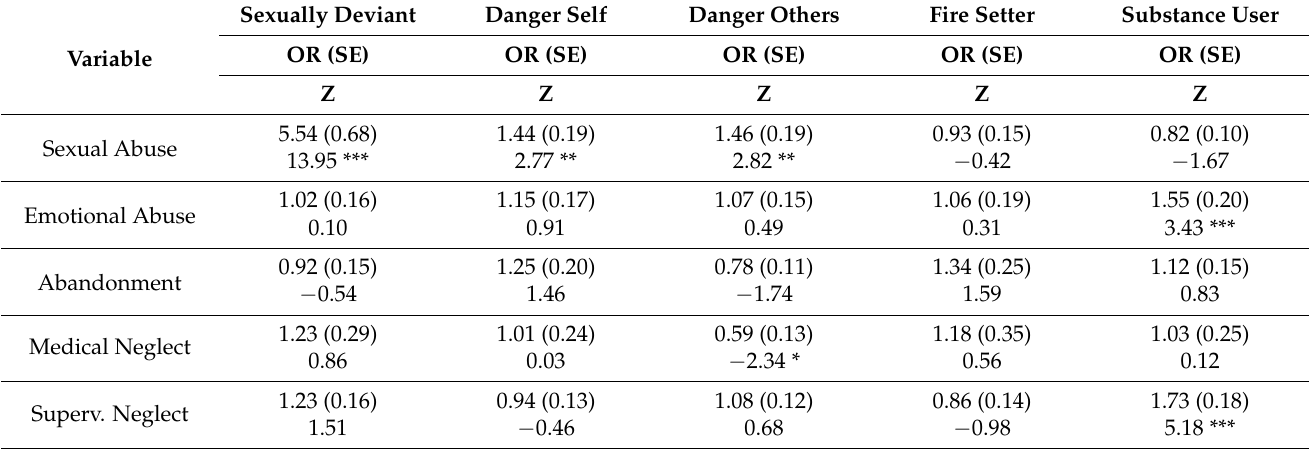
Table 4. Logistic Regression Models for Forensic Typologies for Individual ACEs with